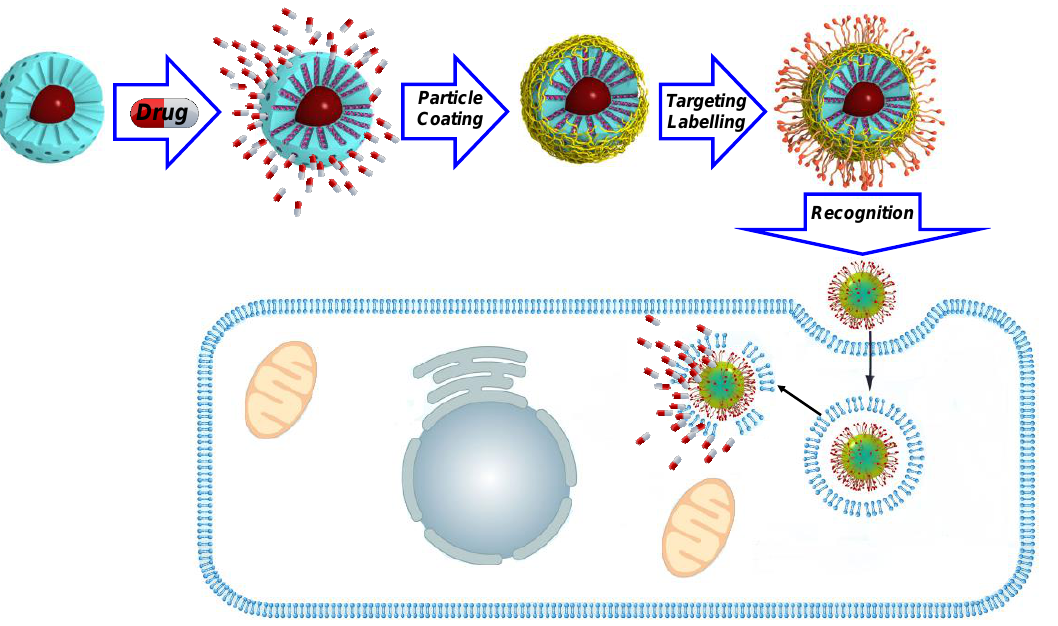
Figure 2. Typical strategy employed for the preparation of drug-loaded, polymer-coated, targeted IOMSNs reviewed herein.